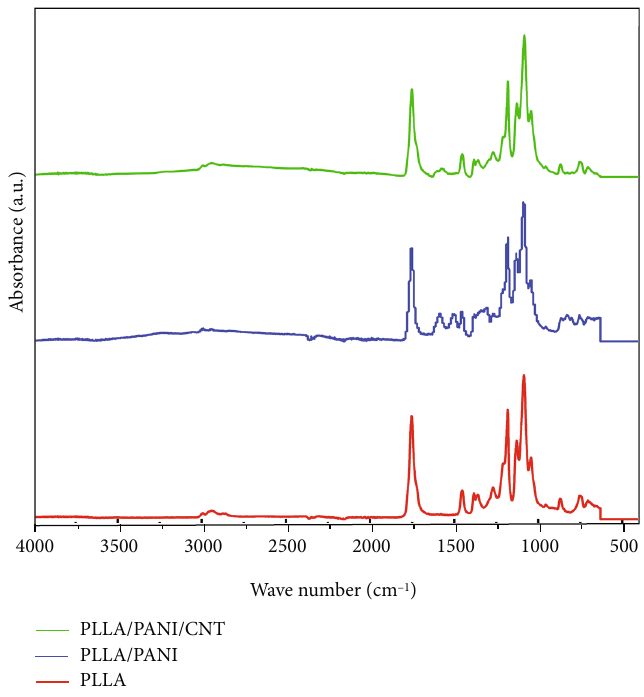
Figure 2: FTIR spectra of PLLA, PLLA/PANI, and PLLA/PANI/CNT composite nano fi bers.